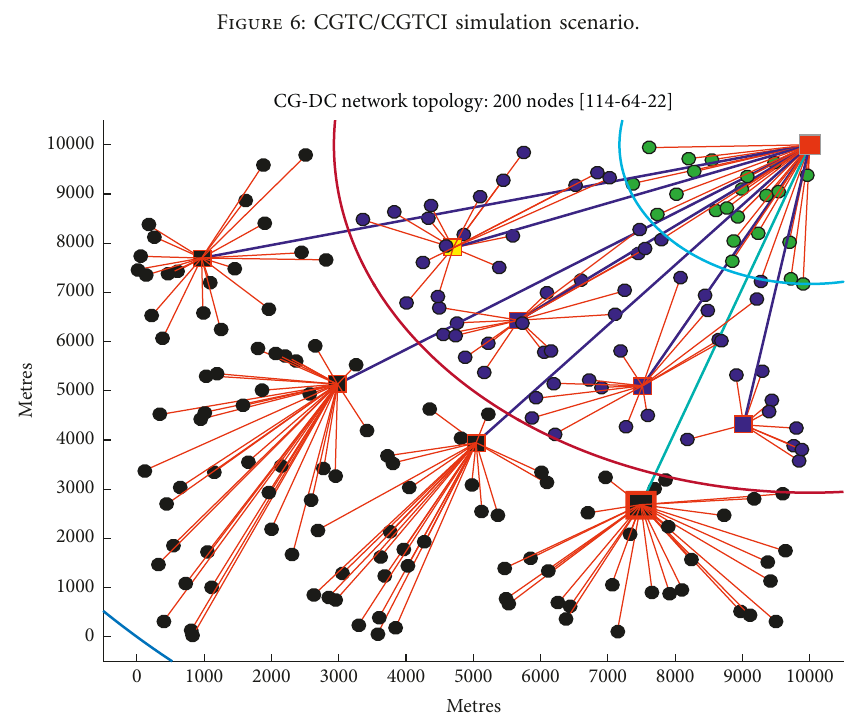
Figure 7: CG-DC simulation